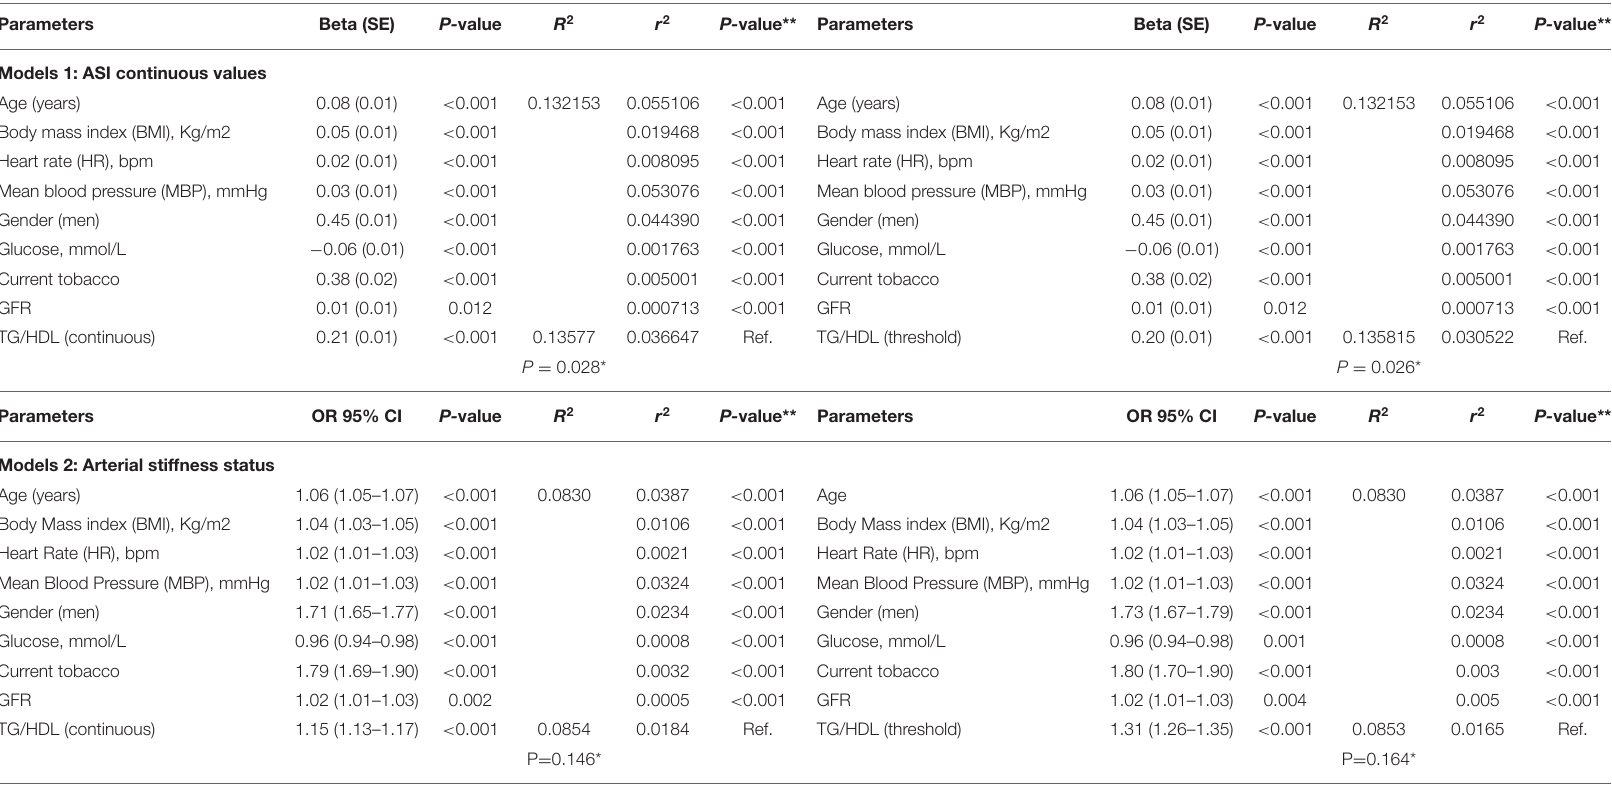
* For comparison of R 2 of adjusted model and the R 2 of adjusted model + TG/HDL. ** For comparison of r 2 of TG/HDL as a reference and the r 2 of the other